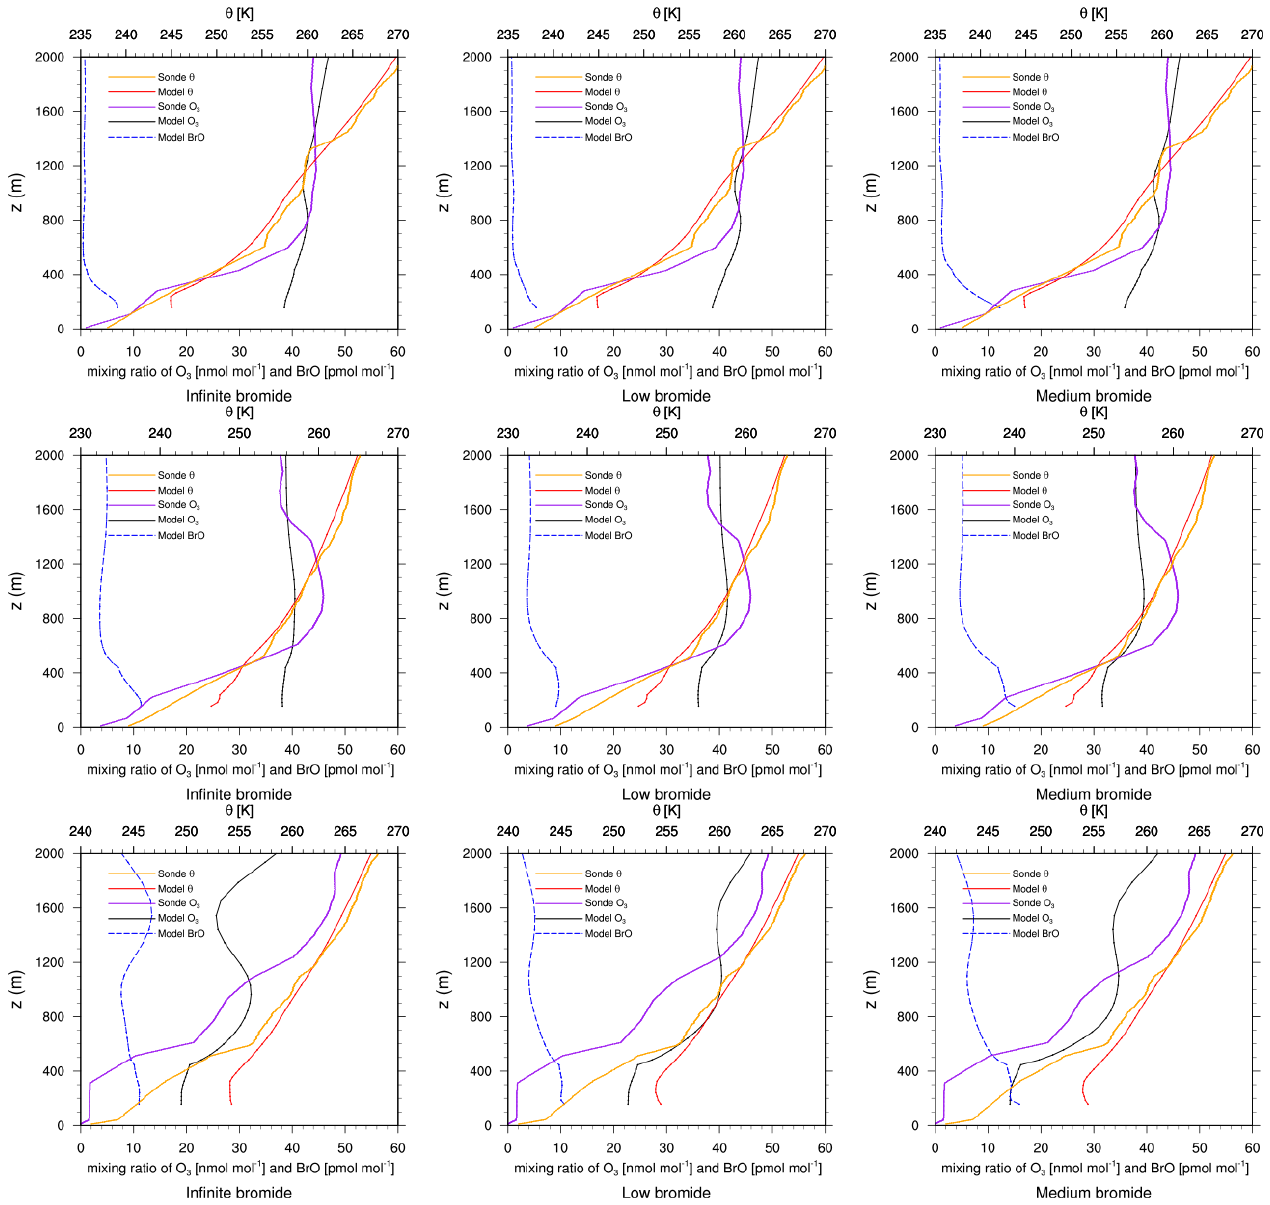
Figure 7. Modeled BrO mixing ratio as well as potential temperature θ and ozone mixing ratios from simulations and from ozone sonde flights against height at Eureka. Columns: infinite FY ice bromide (left), low bromide (center), medium bromide (right). Rows: 21 March 2019 (top), 28 March 2019, (center) 18 April 2019